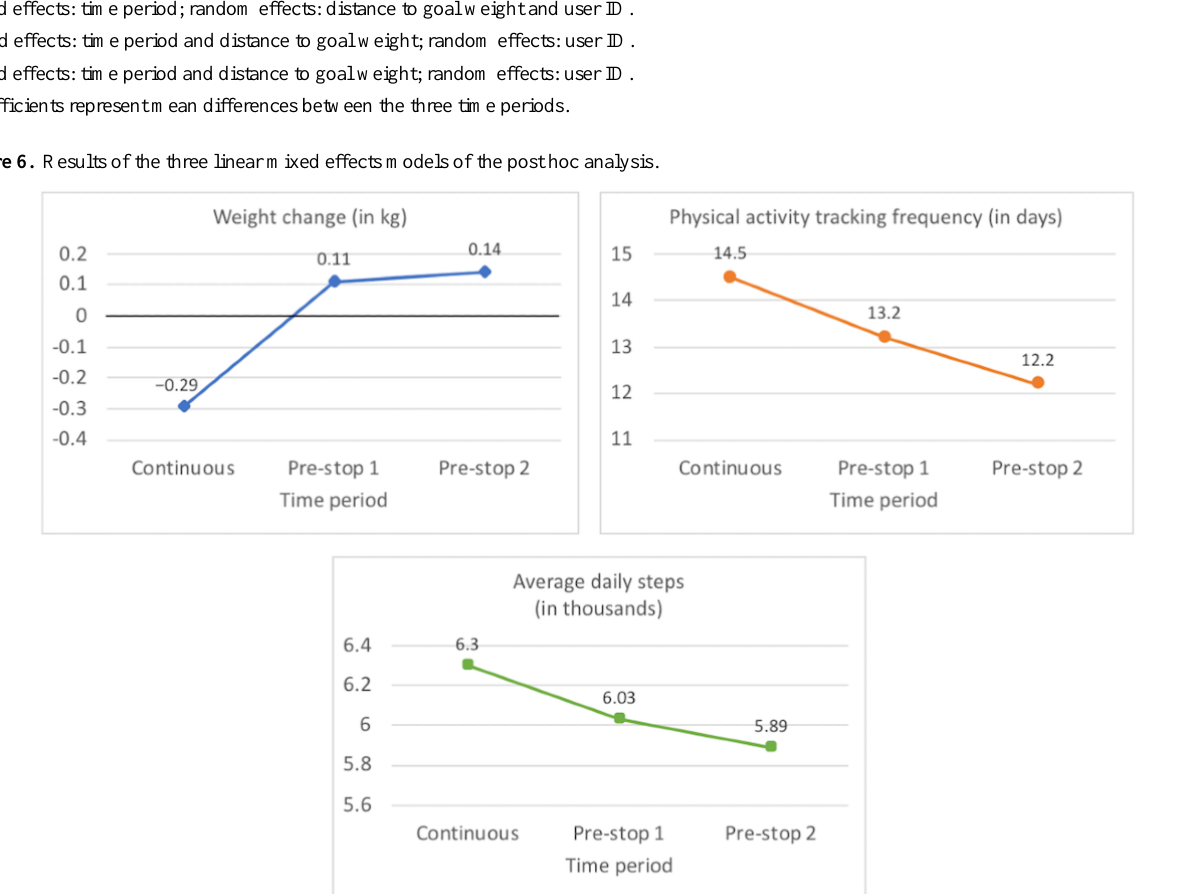
Dependent variablesBest-fitting model